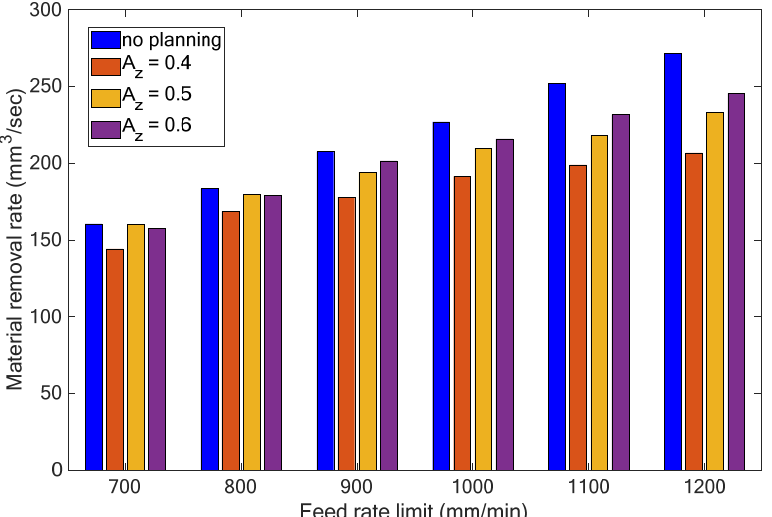
Figure 12. Material removal rates with different feed rate limits and adaptive feed rate planning.